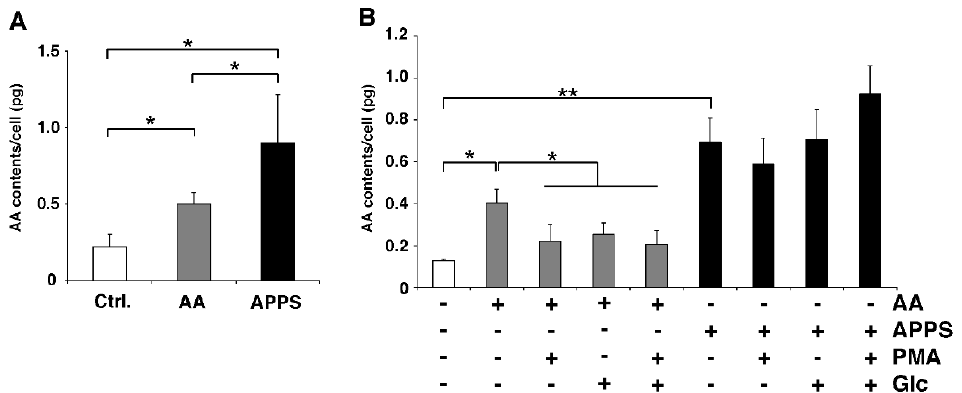
Figure 2. APPS upregulates the cellular AA level in an AA transporter-independent manner. ( A ) Intracellular ascorbic acid (AA) contents in human cells treated with 10 µM AA or 10 µM APPS for 1 h. These data represent the mean ± SE; * p < 0.05; ( B ) Intracellular AA contents in human cells. Human cells were pre-incubated with or without 10 µM PMA and 10 µM glucose for 1 h. After pre-incubation, cells were washed and cultured for 1h in culture medium with or without 10 µM AA and 10 µM APPS. These data represent the mean ± SEM; * p < 0.05 vs. no treatment control, ** p < 0.01 vs. no treatment control.